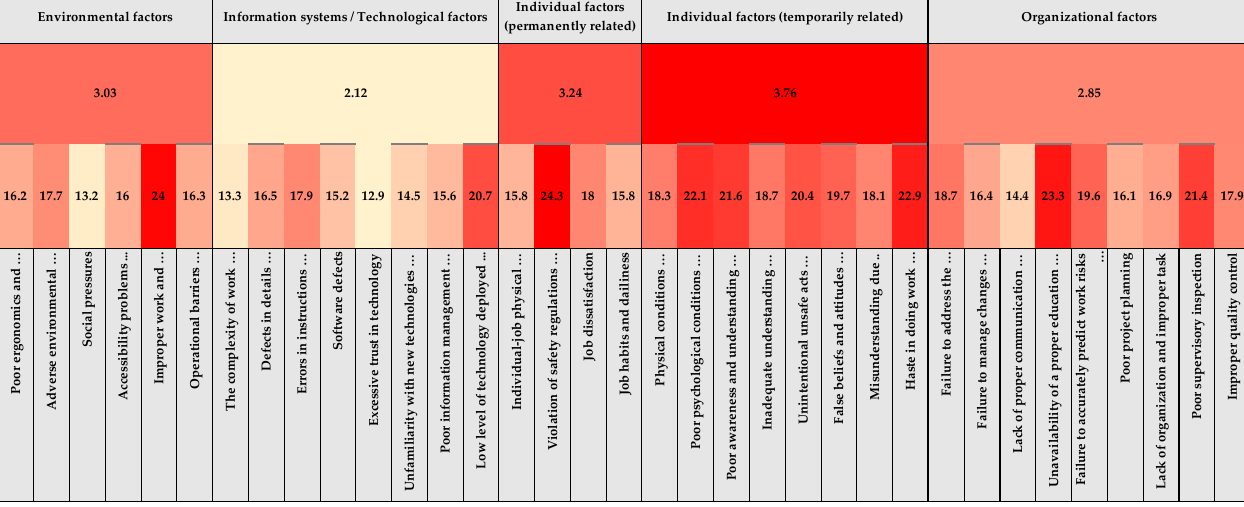
Figure 2. Heatmap delineating the levels of impact of various human error factors leading to the occurrence of site accidents in the UCI of Iran measured by mean ranks (the significance of the factors decline from red to yellow).